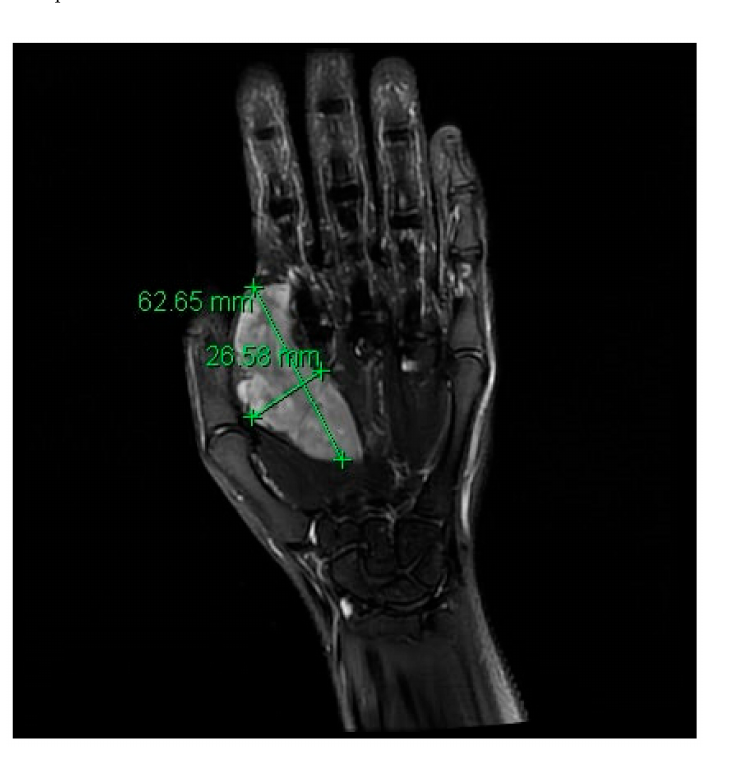
Figure 3. Magnetic resonance imaging revealing the 6.3 × 2.7 cm soft tissue sarcoma of the left